Question: Compose a caption that would accompany this figure in a paper.
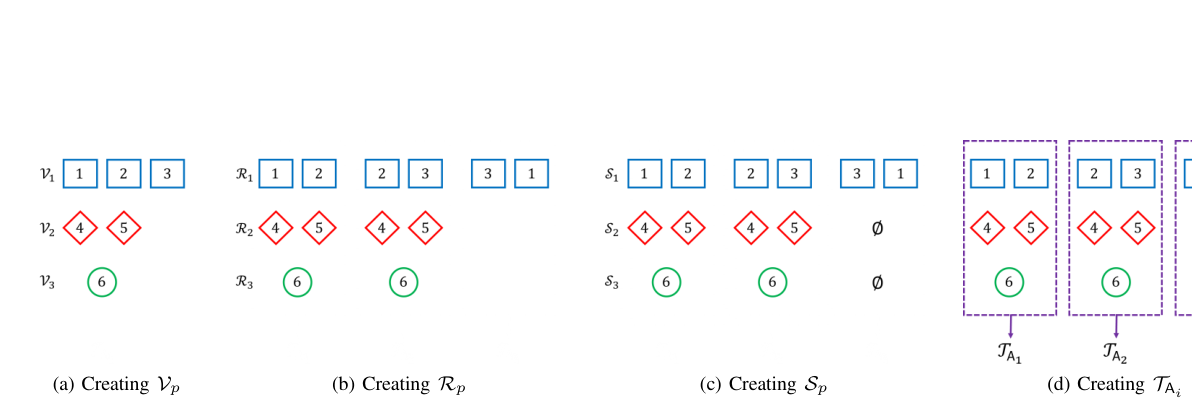
Answer: The elevation process to create the set of served users during the transmission triple Ai for Strategy A in a network with γ = 2